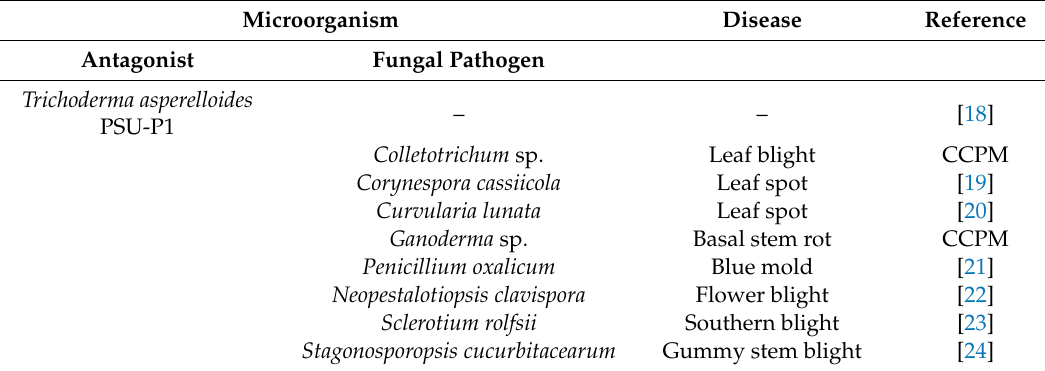
Table 1. List of the microorganisms used in this